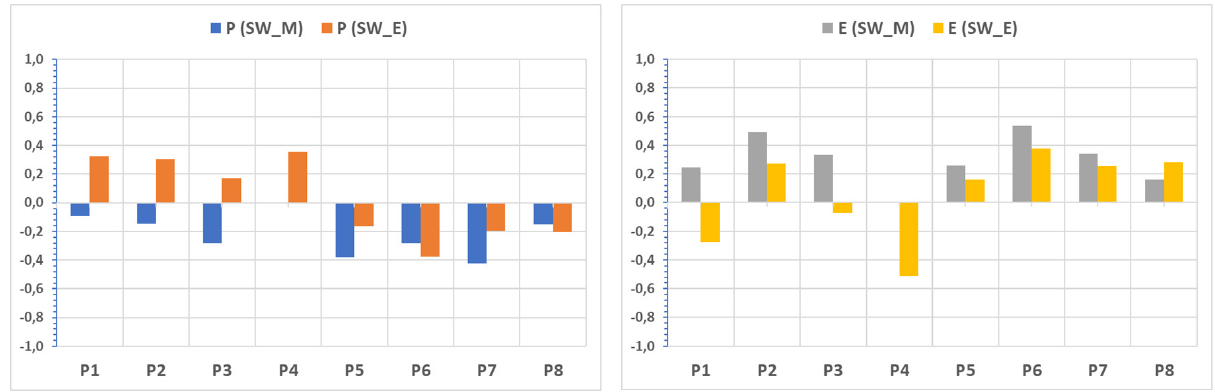
Figure 17: Pleasantness (P, left) and Eventfulness (E, right) morning vs evening comparisons at every stop in the path during soundwalks